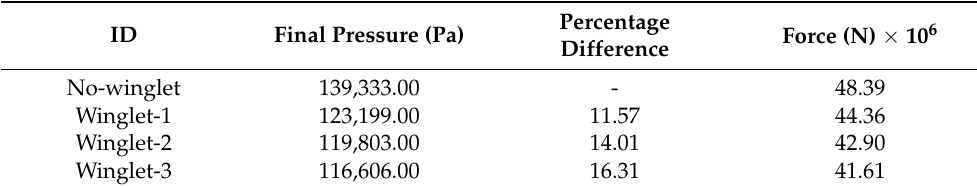
Table 7. Pressure comparison showing percentage difference between each winglet design and a conventional